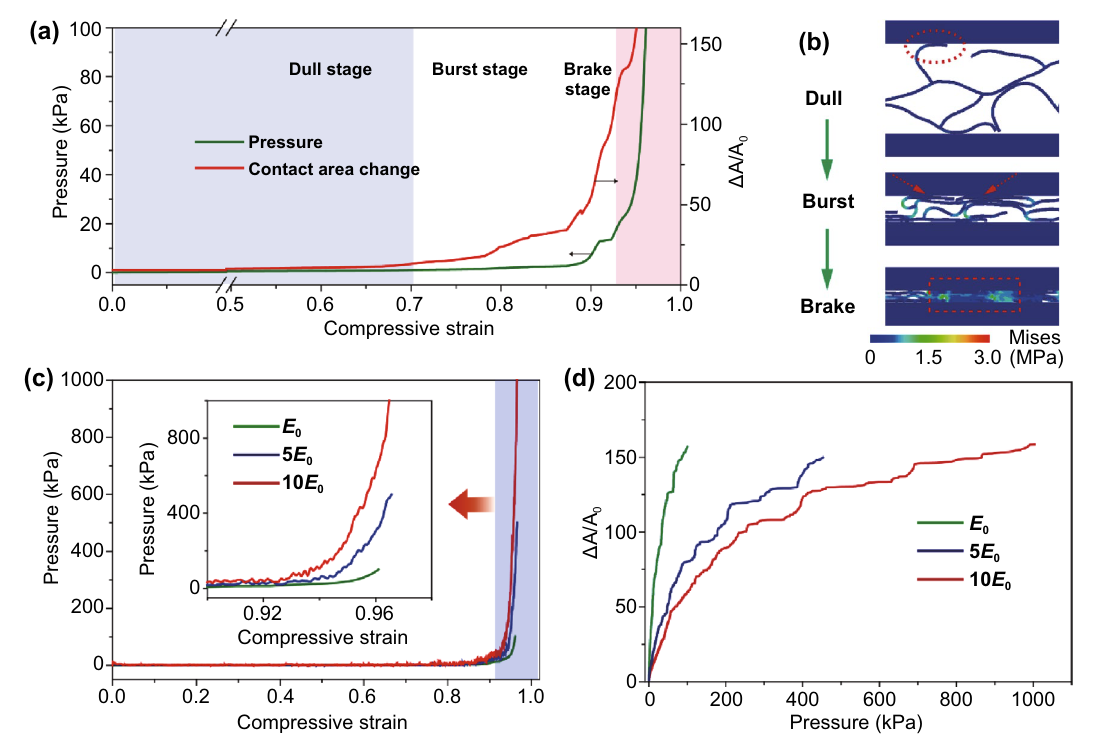
Fig. 2 FEA simulation on the compressibility and change in contact area of the foam. a The evolutions of pressure and normalized contact area in compressive deformation process of a foam with 95% porosity. b Contact forms between ligaments of the foam and electrodes in different compressive stages. c Stress–compressive strain curves of the foam with 95% porosity and different material moduli ( E = E 0 , 5 E 0 , 10 E 0 ). d Con- tact area variation between the dielectric layers with different material moduli and electrodes as a function of applied